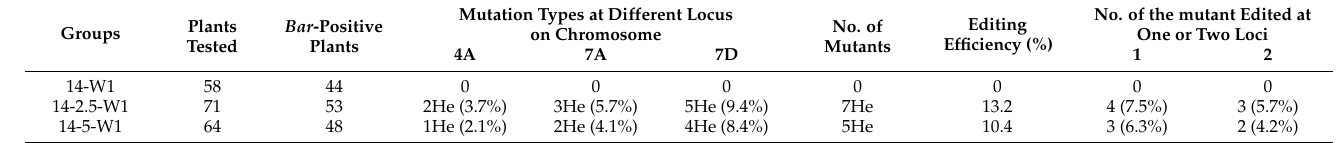
Table 2. The editing efficiency of TaWaxy gene after nicotinamide treatment of the immature embryos of the transgenic plants which carry genome editing vectors (hemizygous) and without mutation in different concentrations.